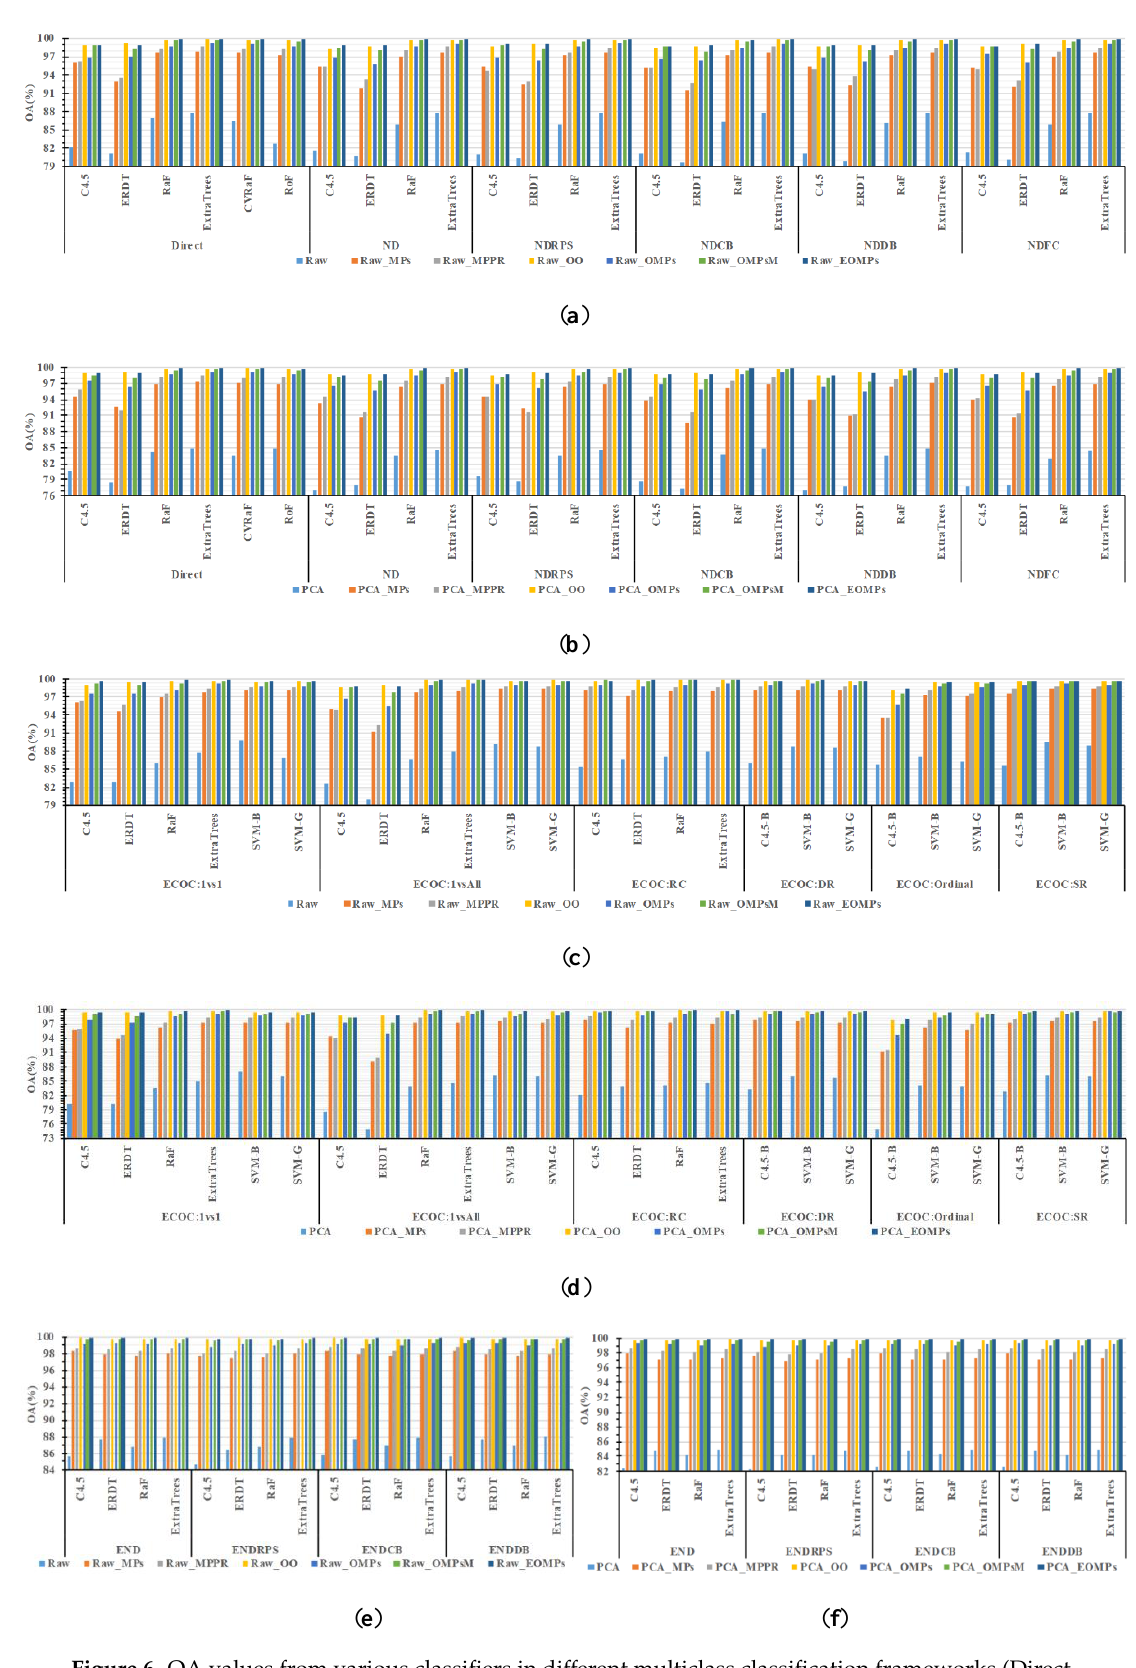
Figure 6. OA values from various classifiers in different multiclass classification frameworks (Direct and ND: a, b; ECOC: c, d; END: e, f) using all the considered features.